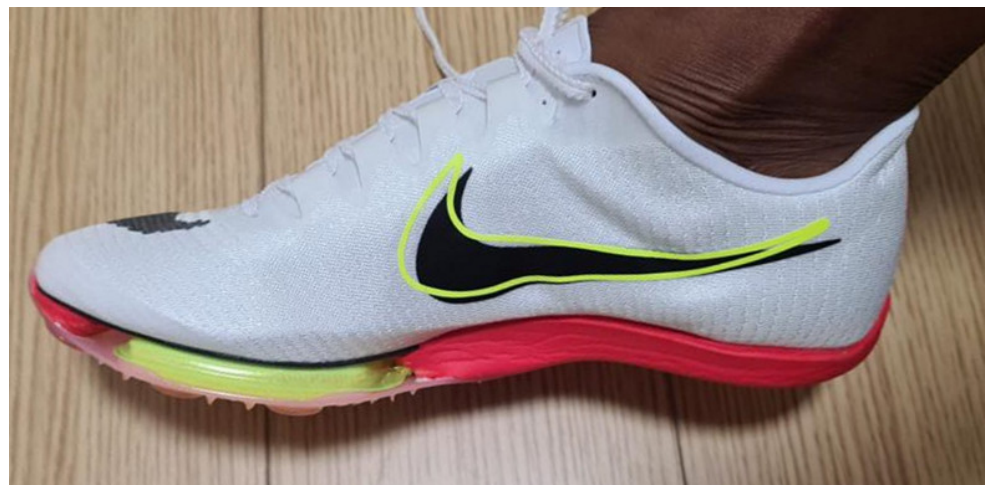
Figure 2. SSS Nike Air Zoom Victory 2021.